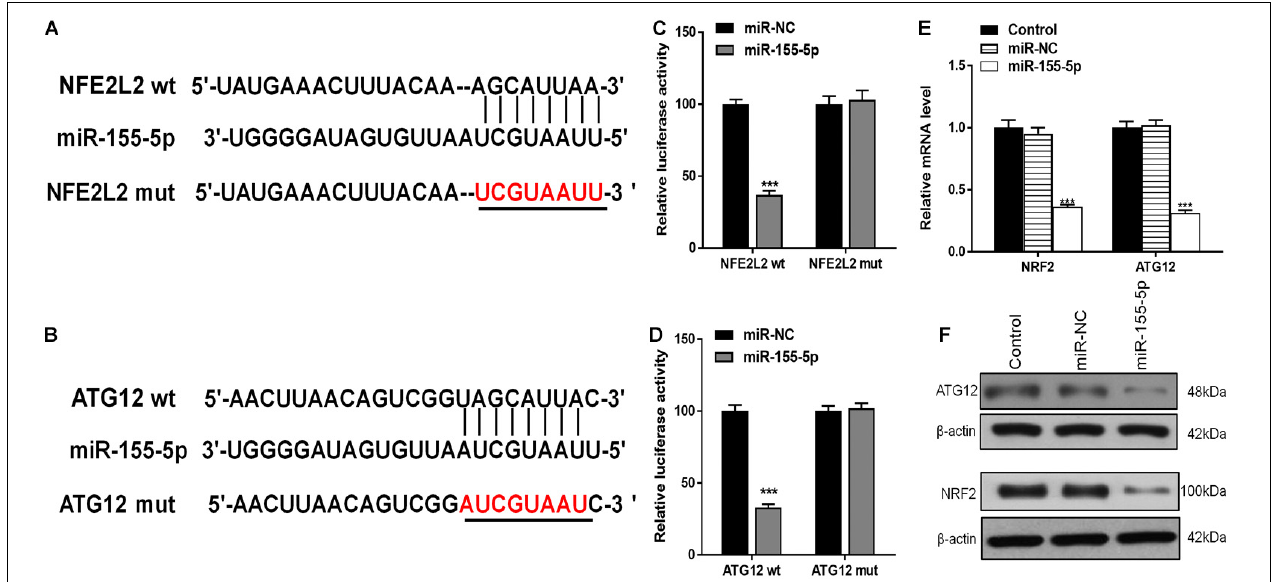
FIGURE 8 | miR-155-5p directly targets and inhibits ATG12 and NRF2. (A,B) The predicted binding sites of miR-155-5p in the 3 (cid:48) -UTR of ATG12 and NRF2. The mutated version of the ATG12 and NRF2 3 (cid:48) -UTR is shown. (C,D) Relative luciferase activity as detected by luciferase assays in astrocytes. (E,F) Cellular ATG12 and NRF2expression as determined by RT-PCR and western blotting. Data are expressed as the mean ± SEM, each experiment was repeated three times. *** p < 0.001 vs.